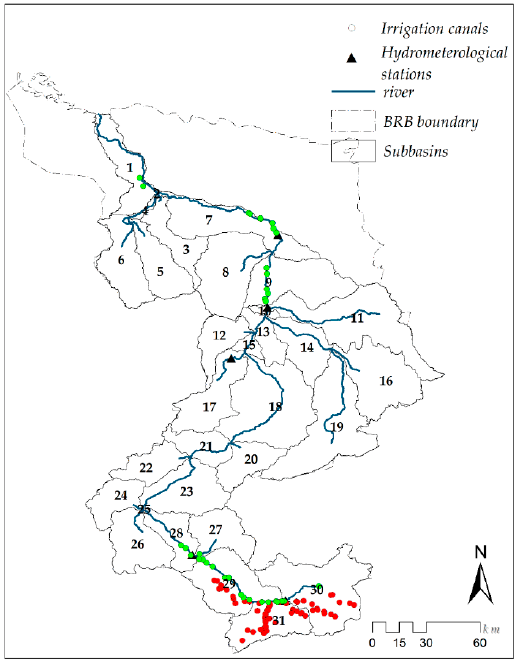
Figure 4. The irrigation canal locations along the BRB were based on their geographical locations according to the data provided by the Northern River Basin Authority of the Islamic Republic of Afghanistan. The irrigation canals with green colors are fed by the Balkhab River, whereas the red colours indicate the canals fed by springs or temporary flows.